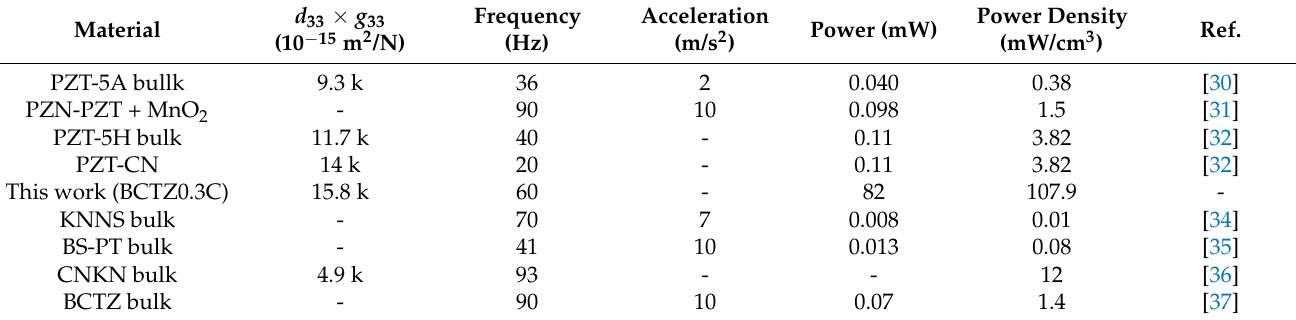
[37] The experimental setup that was used to measure the output power and the displace- ment generated via piezoelectric energy harvesting driven by a Helmholtz coil is shown in Figure 3a. The LPEH has a tip magnet that indicates the energy harvester response of the designed cantilever structure. It has a permanent Nd magnet at its tip, which bends when an external magnetic AC field at 60 Hz is applied. The field is generated using the Helmholtz coils. Using a power amplifier and a function generator, the magnetic field of the Helmholtz coil was adjusted over the range of 140–250 µ T and the magnetic field generated was measured using a tesla meter. In Figure 3b, these LPEHs were gener- ated at various frequency conditions of the maximum power-generation characteristics of the BCTZC 0.3 films at a sintering temperature of 1450 ◦ C. To measure the resonance frequencies (Hz) of the fabricated LPEHs, we used Equation (2) with the following terms: E = Young’s modulus; L = beam length; I = moment of inertia; and m = tip mass. The physical properties of the LPEH (e.g., its length, mass, area, thickness, and Young’s mod- ulus) determine its operational performance. The LPEH was designed to be tuned for a resonance frequency of 60 Hz. The calculated LPEH resonance frequency was about 60 Hz: